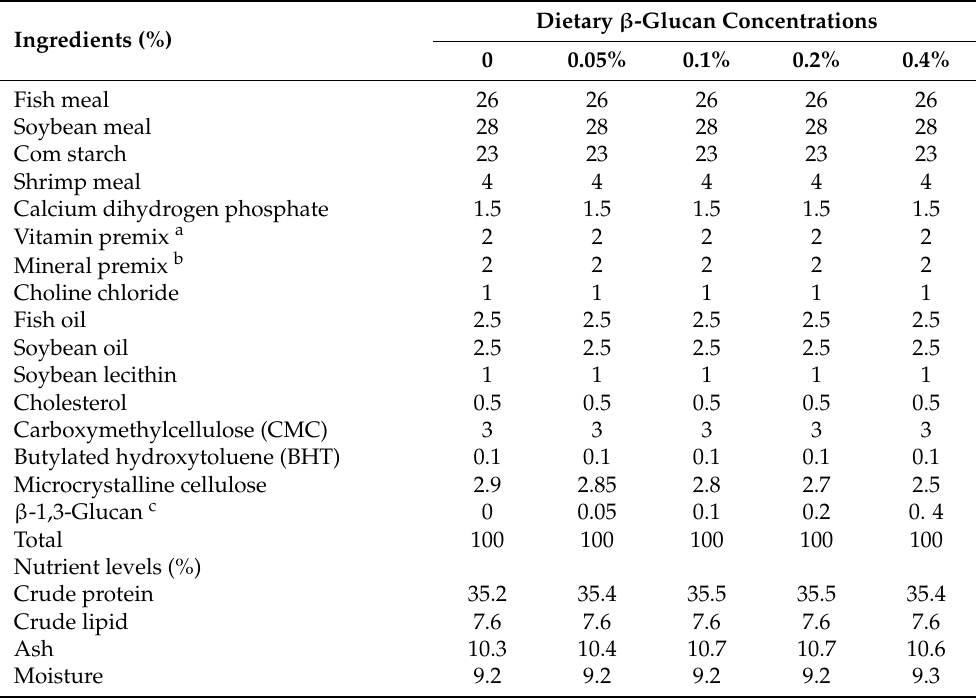
Table 1. Dietary formulations and proximate composition of the experimental diets (% dry